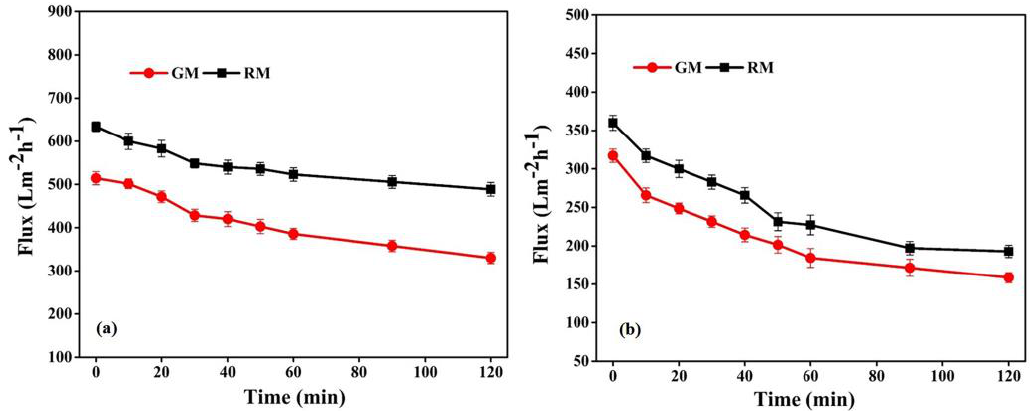
Figure 10. Flux with respect to ( a ) pure water and ( b ) BSA solution for resin and gel membrane.